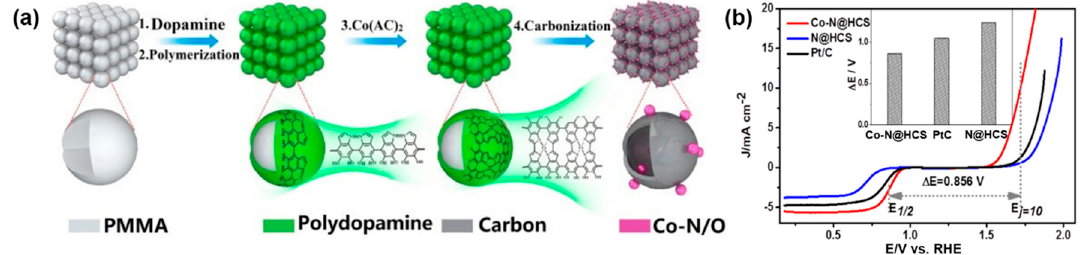
Figure 9. ( a ) The schematic chemical synthesis route of Co–N@HCS catalyst; ( b ) the LSV curves within ORR (cathodic sweep) and OER (anodic sweep) potential window of Co–N@HCS, N@HCS and Pt/C catalysts in O 2 -saturated 0.1 KOH at a rotation speed of 1600 rpm with a mass loading of 0.3 mg cm − 2 . Inset: the comparison of the ∆ E values. Reproduced from [115], Copyright © Elsevier, 2017.